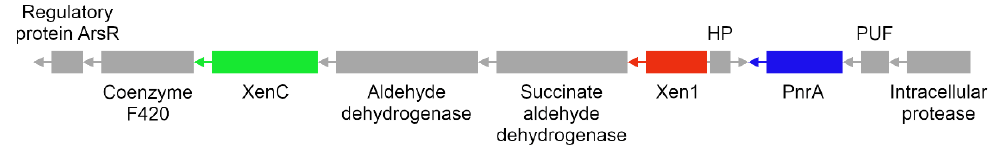
Figure 5. Putative gene cluster encoding TNT-degrading enzymes in P. putida strains JLR11 and KT2440. Xenobiotic reductase C (XenC), xenobiotic reductase 1 (Xen1), hypothetical protein (HP), nitroreductase PnrA (PnrA) and protein of unknown function (PUF). 2,4,6-trinitrotoluene (TNT).